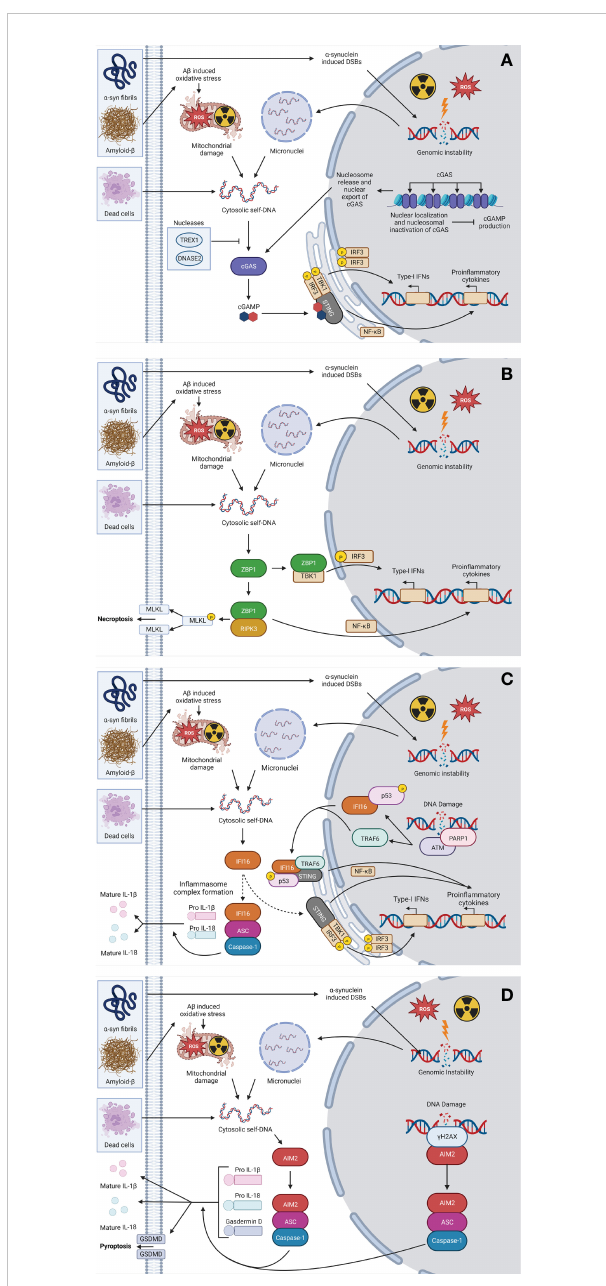
FIGURE 2 Cytosolic self-DNA sensing pathways. In the CNS, the uptake of a - Syn fi brils, amyloid- b , and/or cellular debris by resident CNS cells, or exposure to exogenous oxidative stress or ionizing radiation (IR), can lead to liberation of self-DNA to the cytosol via mitochondrial damage or genomic instability leading to micronuclei formation. The presence of self-DNA in the cytoplasm can then be perceived via DNA sensing PRRs including cGAS (A) , ZBP1 (B) , IFI16 (C) , and/or AIM2 (D) , leading to sensor-speci fi c signaling pathways that precipitate the production of in fl ammatory cytokines, type-I IFNs and/or immunogenic necroptotic and pyroptotic cell death pathways. This fi gure was created with